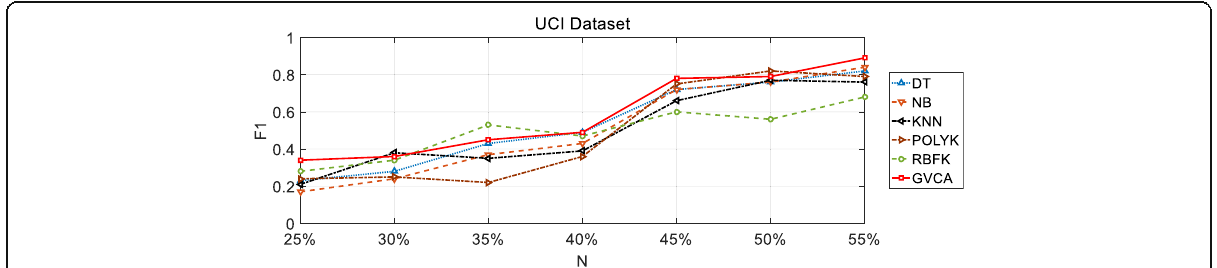
Fig. 2 Comparison of the convergence rate of UCI dataset by the GVCA method and other classification